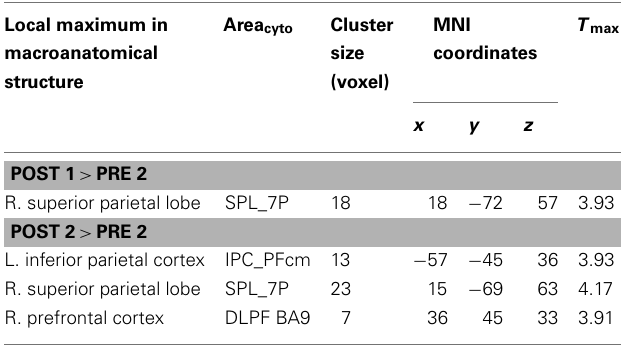
Bold, significant improvement compared to pre 2 ; fMRI spatial attention (%): % of detected left sided stimuli; fMRI spatial attention (RT), median reaction time (ms) of stimuli detected on the left side. Table 7 | Macroanatomical structure, cytoarchitectonical area (Area cyto ), cluster size in voxel, MNI coordinates ( x , y , z ), and maximum T value ( T max ) of the local maxima from the direct contrasts of post combined training against baseline (post 1 > pre 2) and long term effects (3 >